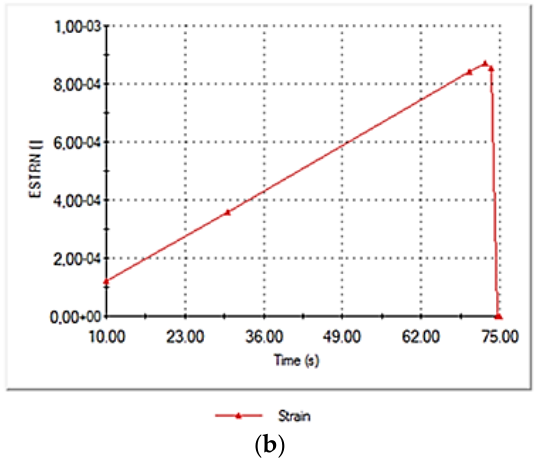
Figure 9. ( a ) Three-dimensional (3D) model highlighting equivalent strain; ( b ) equivalent strain vs. time for the model with 1 mm cut.